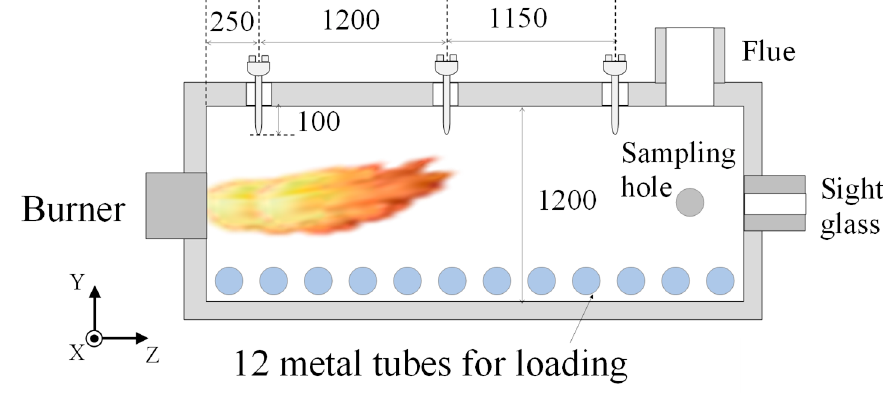
Figure 1. Test furnace size.